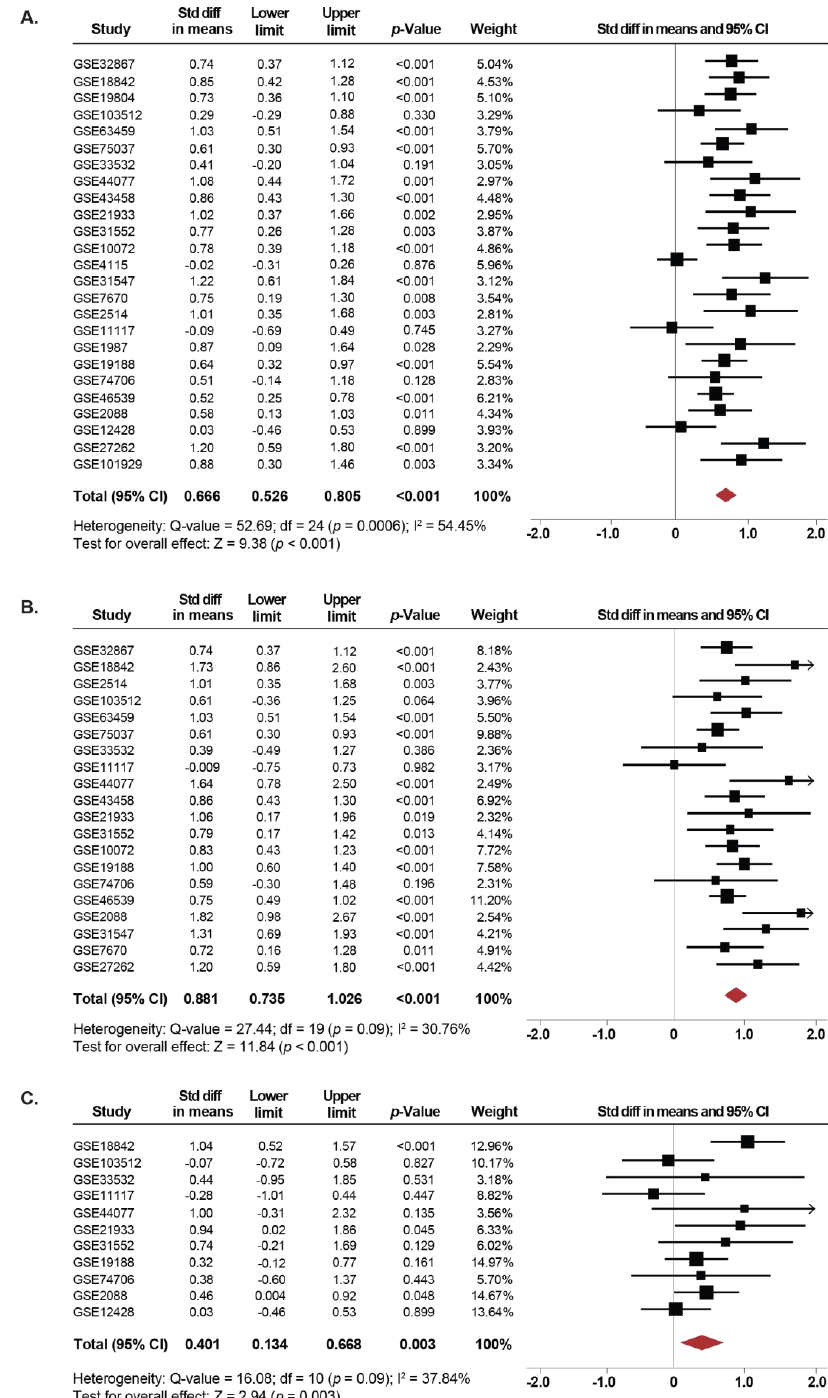
Figure 2. SETDB1 mRNA expression is significantly increased in NSCLC patients. ( A ) Forest plot of standardized mean difference (SMD) comparing SETDB1 mRNA levels in NSCLC patients and non-cancerous controls, including adjacent non-cancerous specimens that were resected from NSCLC patients or normal specimens from a healthy control. ( B ) and ( C ) Subgroup meta-analysis of the SETDB1 mRNA levels between ADC patients ( B ) and SCC patients ( C ) compared to non-cancerous controls. Standardized mean di ff erences for each dataset are represented by the squares, and the horizontal line crossing the square represents the 95% CI. The diamonds represent the estimated overall e ff ect. The arrows indicate that the upper limit of the SMD is higher than